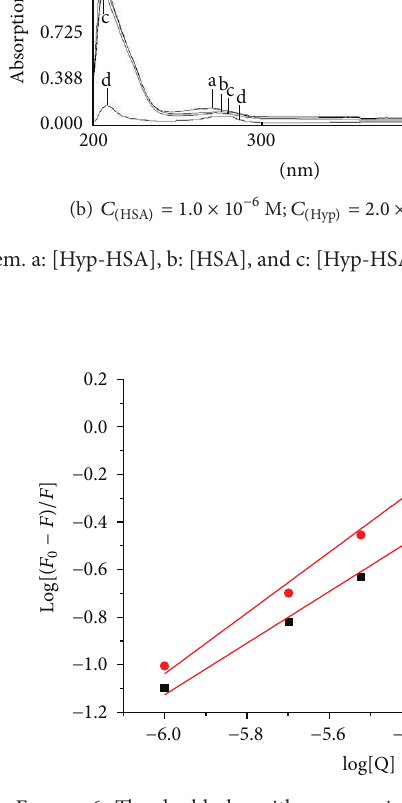
Figure 6: The double logarithm regression plots of Hyp-HSA at = 1, 2, 3, 4, 5, 6, 7 × 10 −6 M. different temperatures, 𝐶 ( HSA )